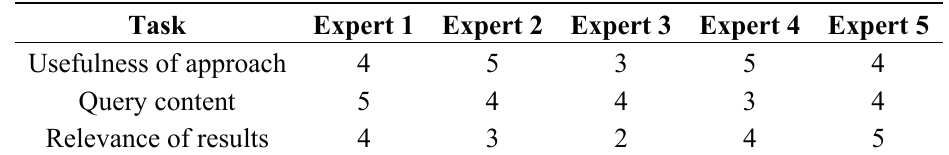
Figure 9. Manual query writing time in minutes for expert and average users. Table 5. User satisfaction based on overall impression for each task with the proposed approach (1= very negative, 5 = very